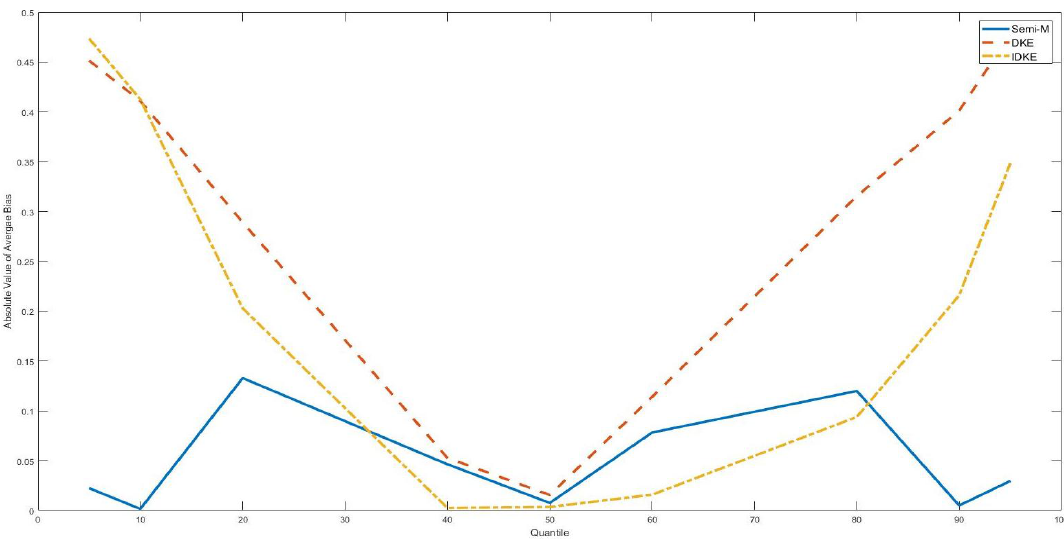
Figure 2. Average bias with γ 0 as various quantiles of the threshold variable, DGP 2, n = 300. This figure shows absolute values of the average bias with the true threshold level being several quantiles of the threshold variable (5th,10th,20th,40th,50th,60th,80th,90th,95th). The simulation is based on DGP 2. The sample size is